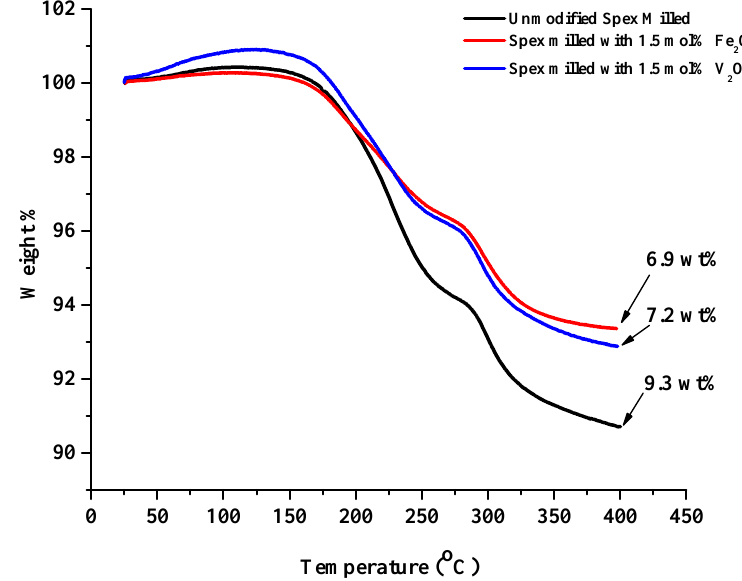
:MgH mixture at 5 °C/min from 30 °C to 400 °C. The initial 2 2